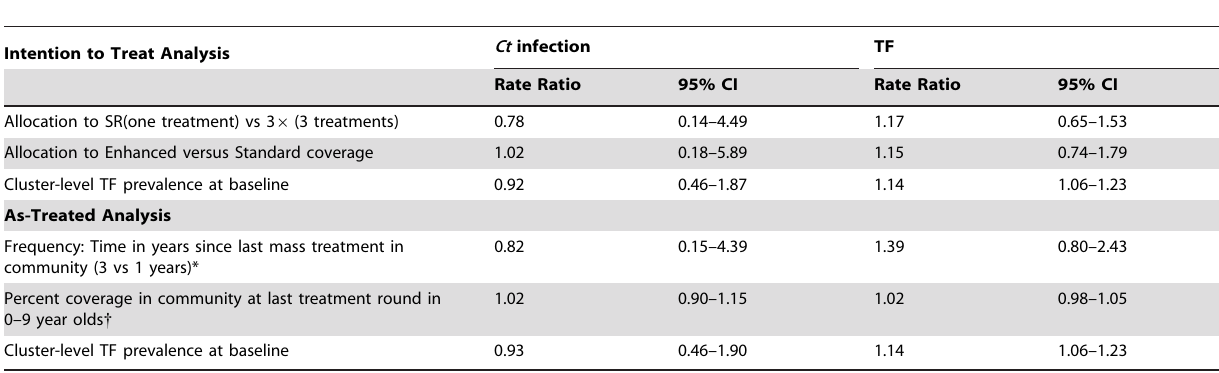
Table 4. Impact of mass treatment delivery strategies on Ct infection and TF at 36 months.